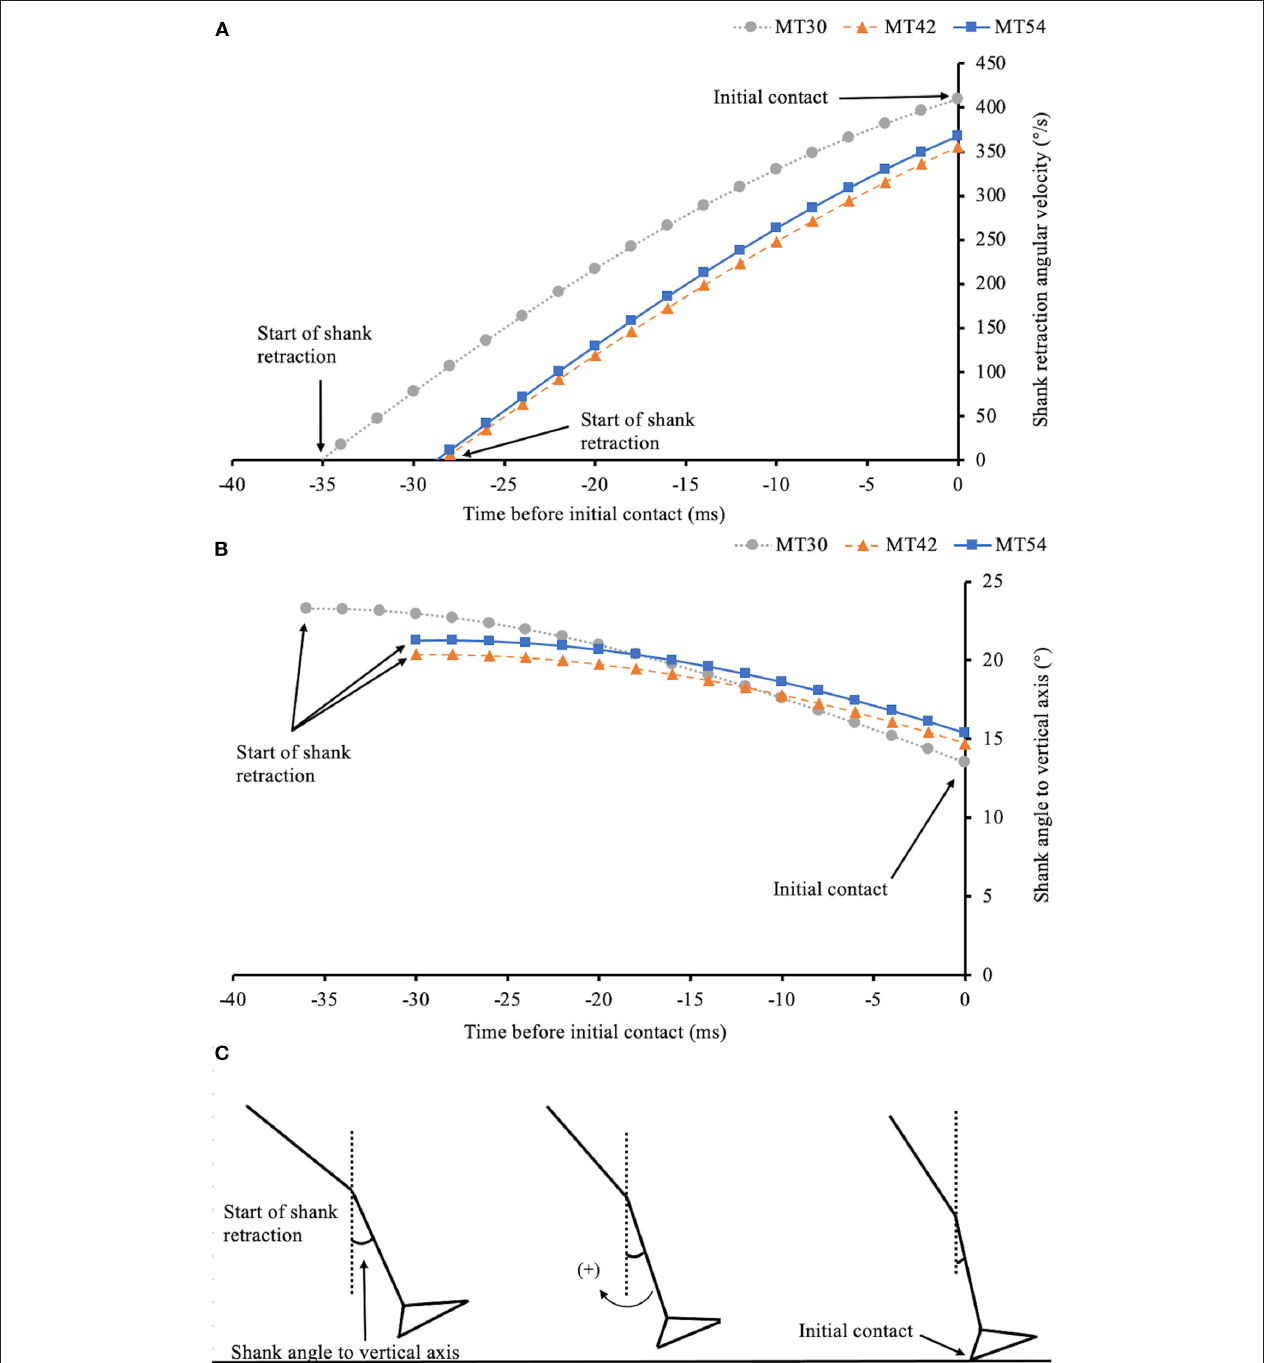
FIGURE 5 | Retraction angular velocity (A) and angular displacement (B) of the shank prior to IC for a typical trial in each shoe condition for one of the subjects. The schematic stick figure (C) illustrates the evolution of shank retraction. Notice that an earlier initiation of retraction motion in the thinner shoe midsole condition (i.e., MT30) does not influence much the posture of the shank at initial ground contact but leads to an increased retraction angular velocity of the shank at IC. The same convention of shank retraction angular velocity applies to Figure 4C